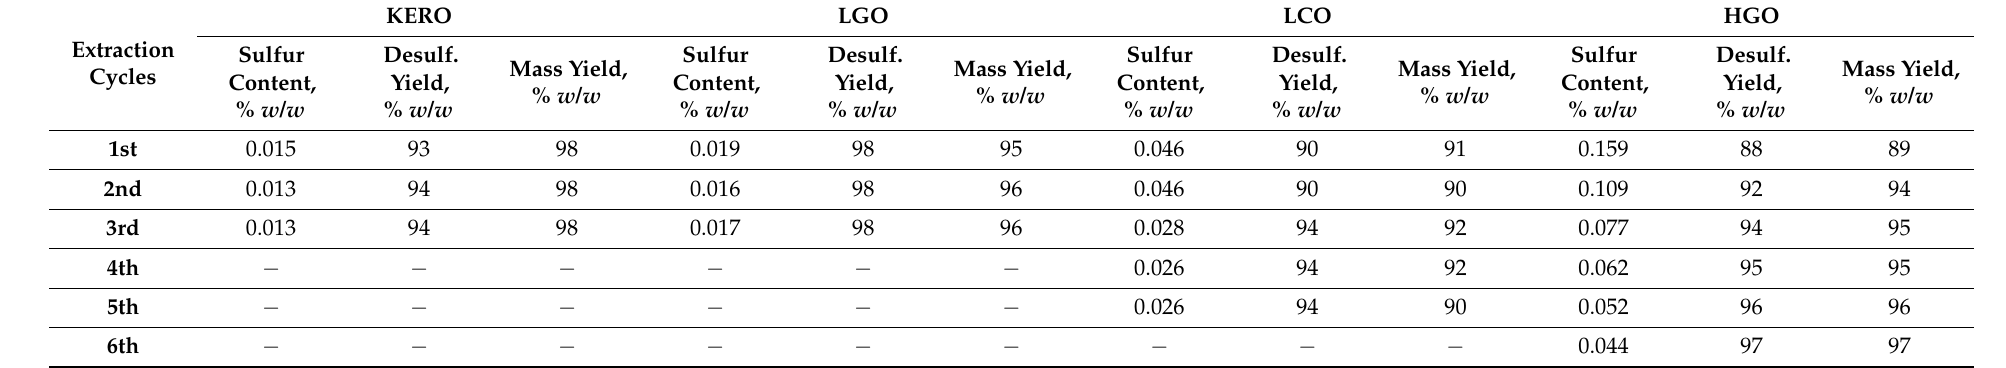
Table 8. Sulfur content, desulfurization yield and mass yield of the surrogate raffinates during the multiple-stage extractions with fresh [BMIM][HSO 4 ].